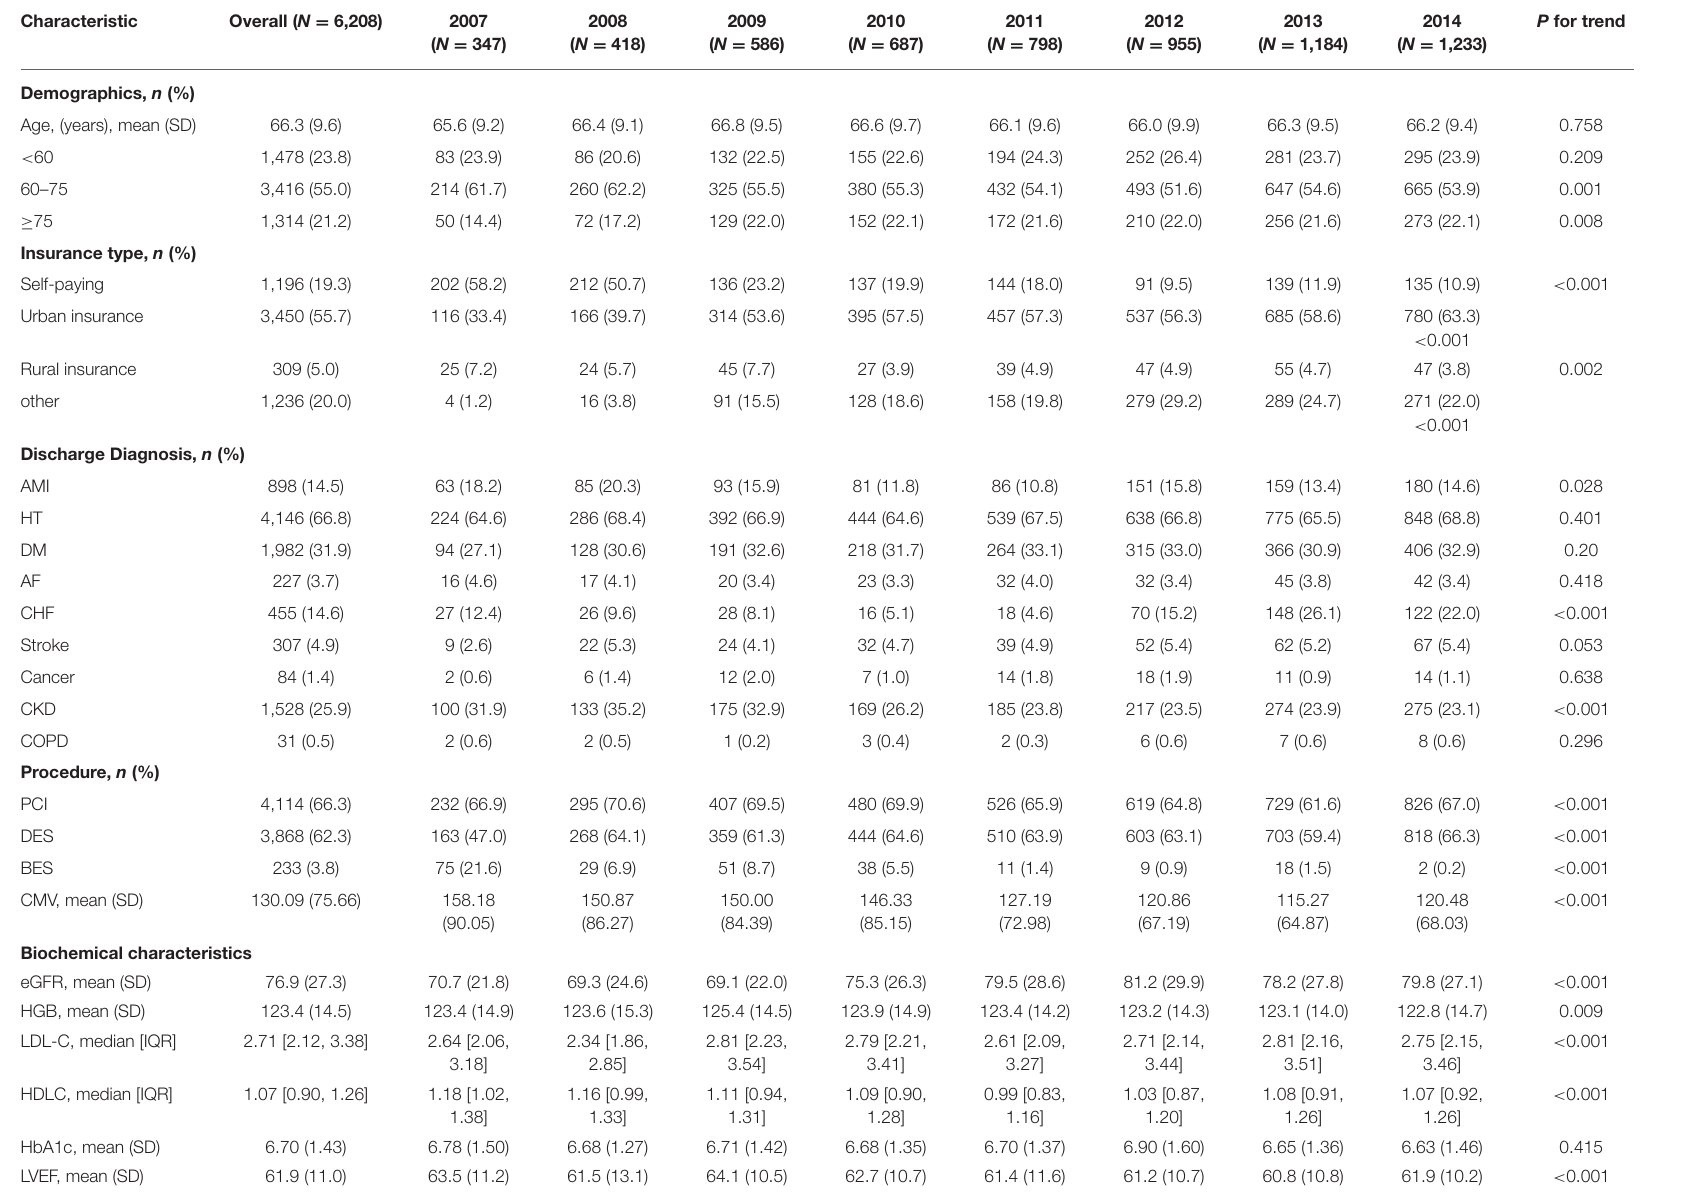
TABLE 3 | Clinical and biochemical characteristics of female patients with CAD from 2007 to